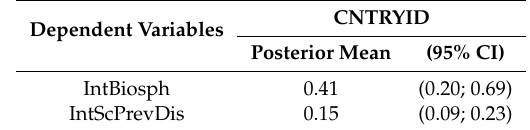
Table A4. Posterior estimates with 95% CI for the random country variations in students Interests.